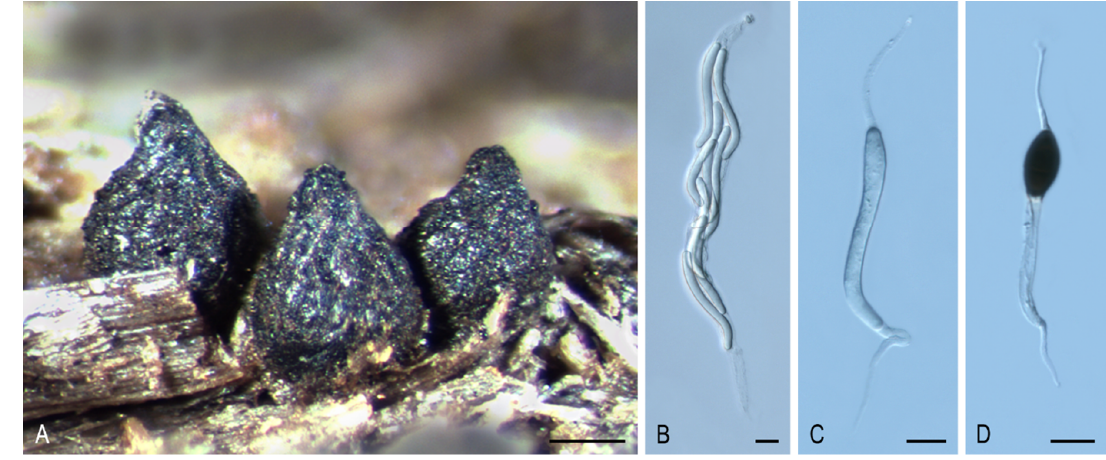
Figure 3 . Areotheca areolata JF05120_ANMAcc49. ( A ) Ascomata. ( B ) Ascus. ( C , D ) Ascospores. Bars: ( A ) = 200 µm; ( B – D ) = 10 µm.